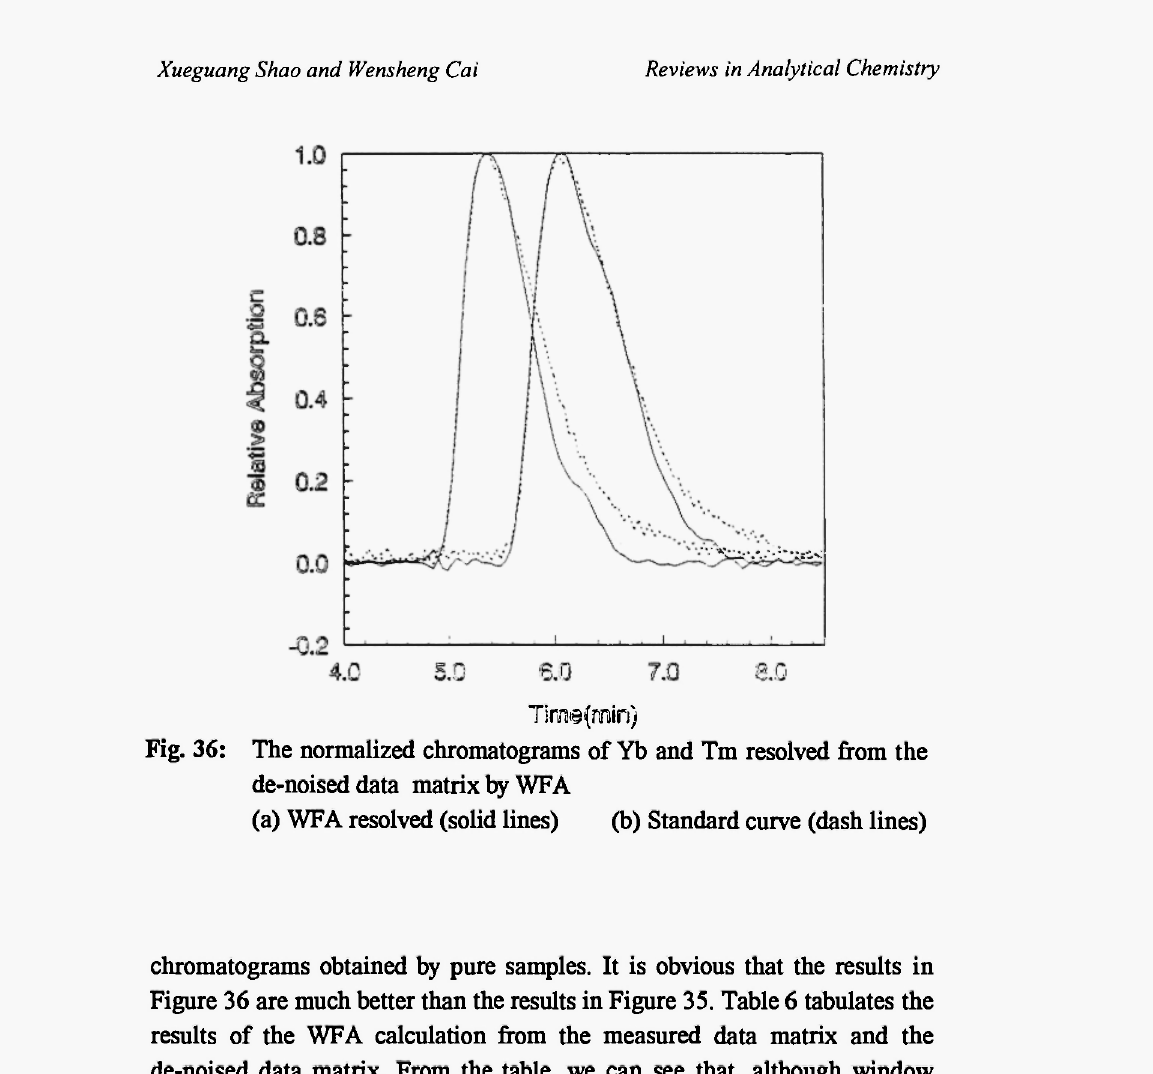
Fig. 36: The normalized chromatograms of Yb and Tm resolved from the de-noised data matrix by WFA (a) WFA resolved (solid lines) (b) Standard curve (dash